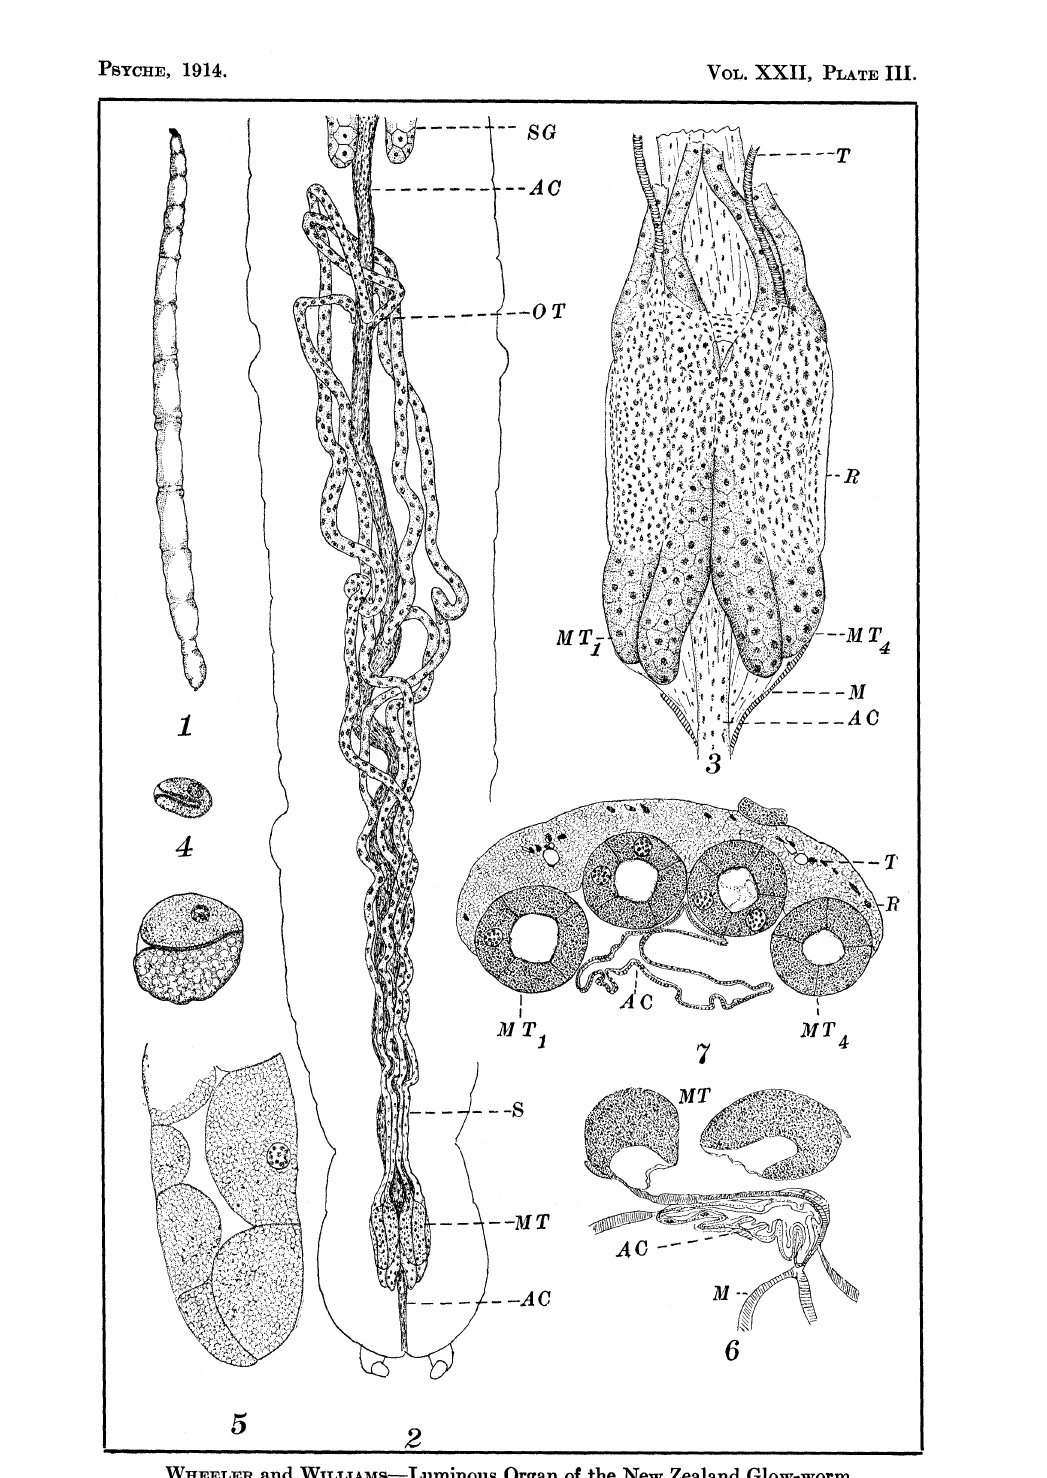
WHEELER and WILLIAMS--Luminous Organ of the New Zealand